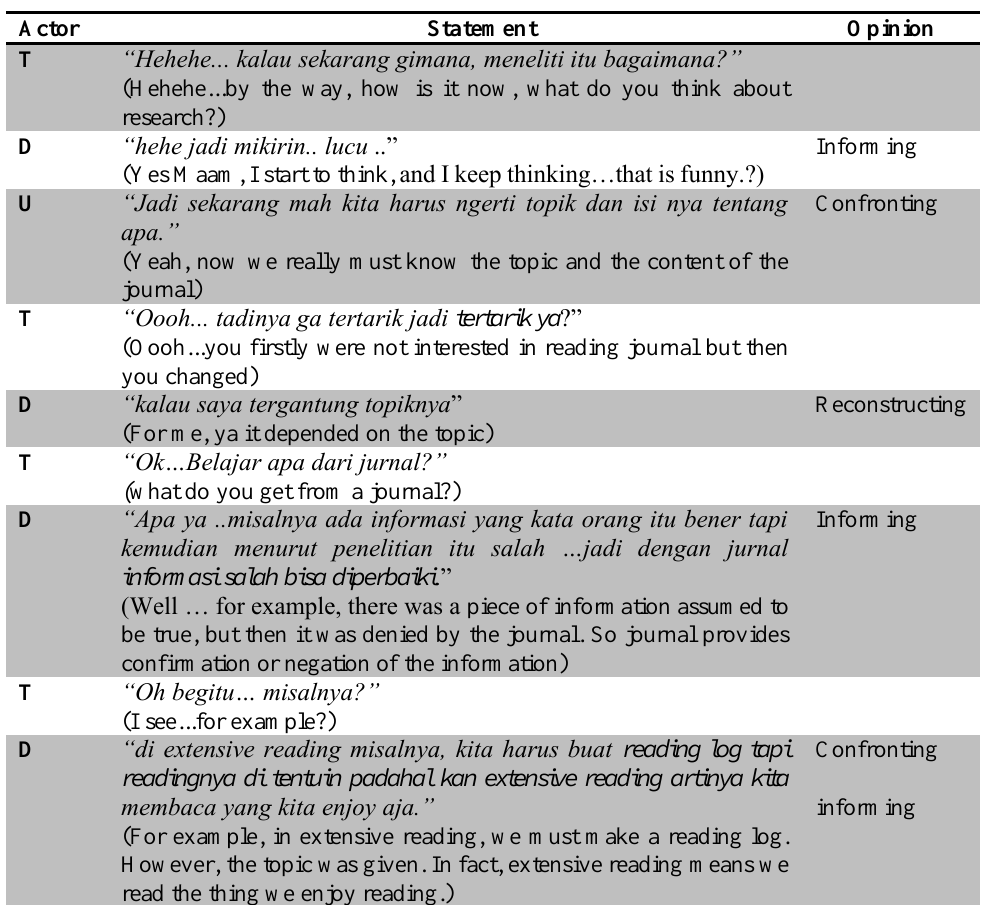
Table 8. Students’